Question: Provide a one-line summary of what is displayed.
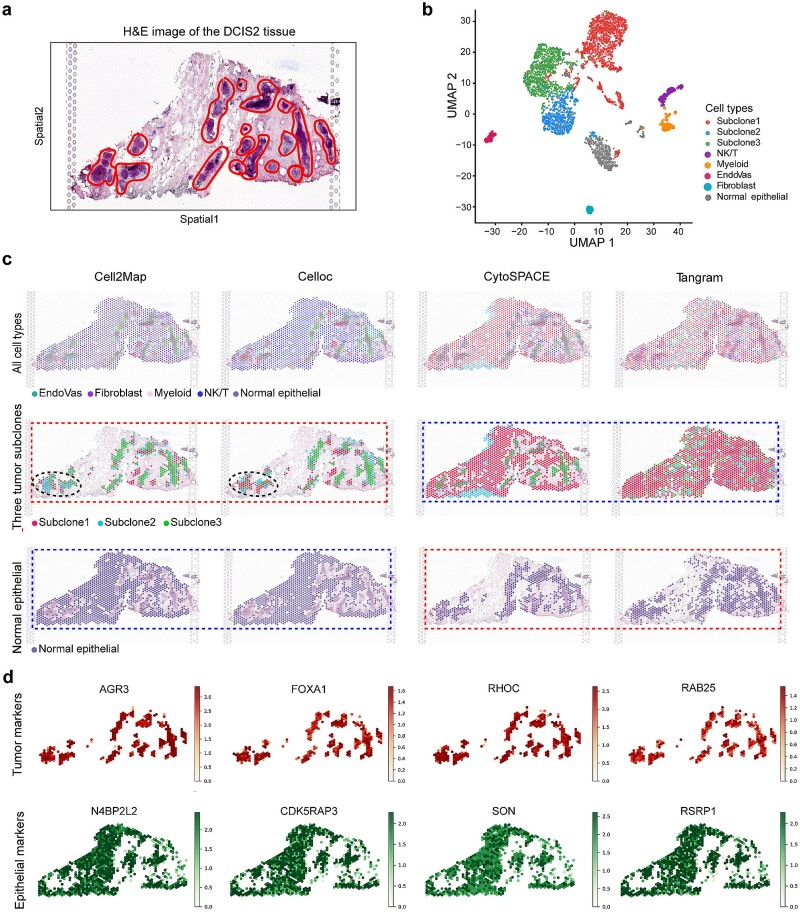
Answer: Visualization of mapping DCIS2 scRNA-seq data to DCIS2 SRT data; (a) the H&E image in the DCIS2 SRT data with histologically annotated ductal tumor regions outlined; (b) UMAP plot of DCIS2 scRNA-seq data 3587 cells annotated with major cell types, including three tumor subclones; (c) spatial mapping results of scRNA-seq onto SRT spots; dashed outlines indicate regions of correct localization and/or mis-localization relative to histologically defined tumor areas, illustrating differences in spatial specificity and tumor-normal separation across methods; (d) spatial expression of markers for tumor and epithelial cells.